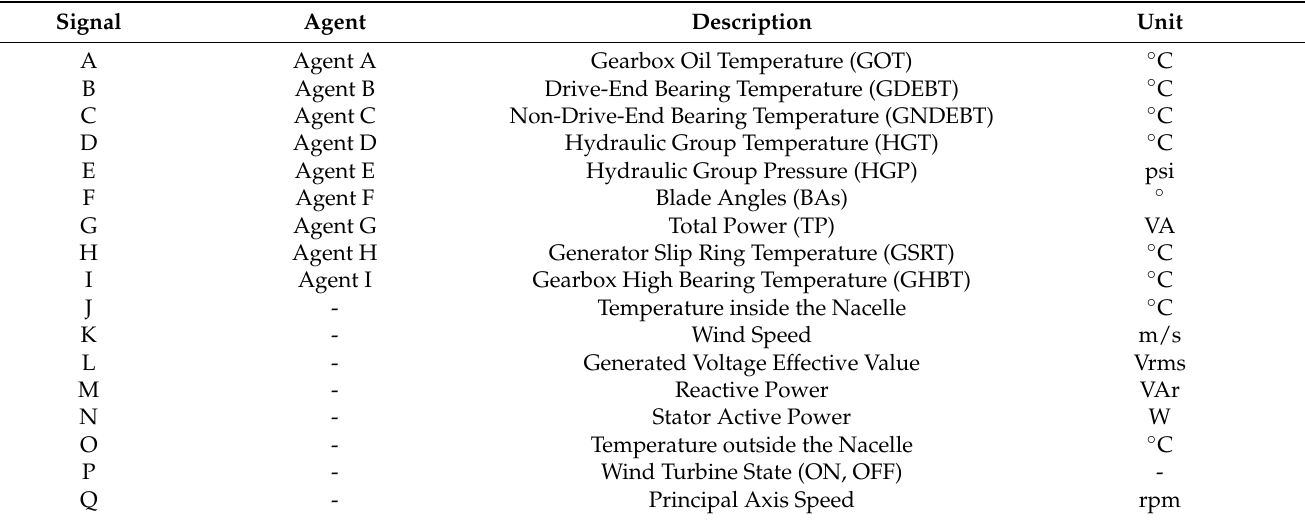
Table 3. Measured signals, agents, description, and unit.